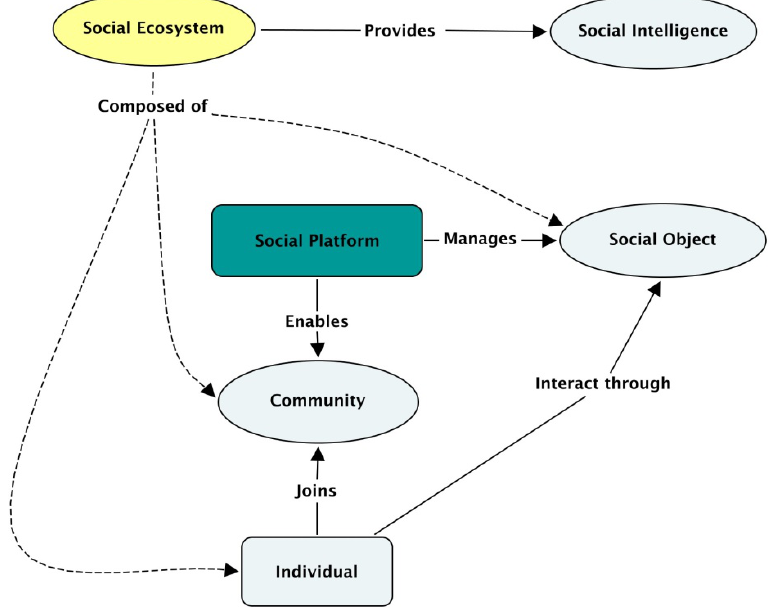
Figure 2. A light model for the Social Web by using concept